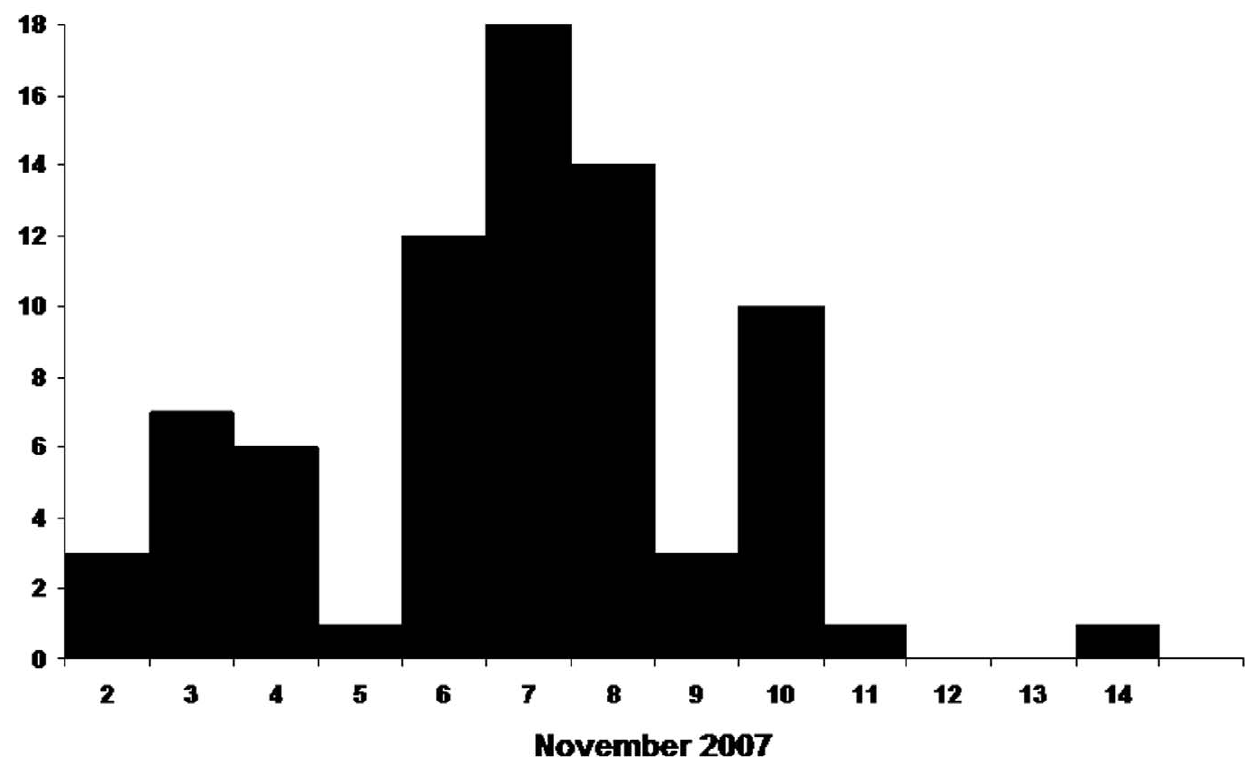
Figure 2. Dates of onset of vomiting in patients identified during the outbreak, n=76.